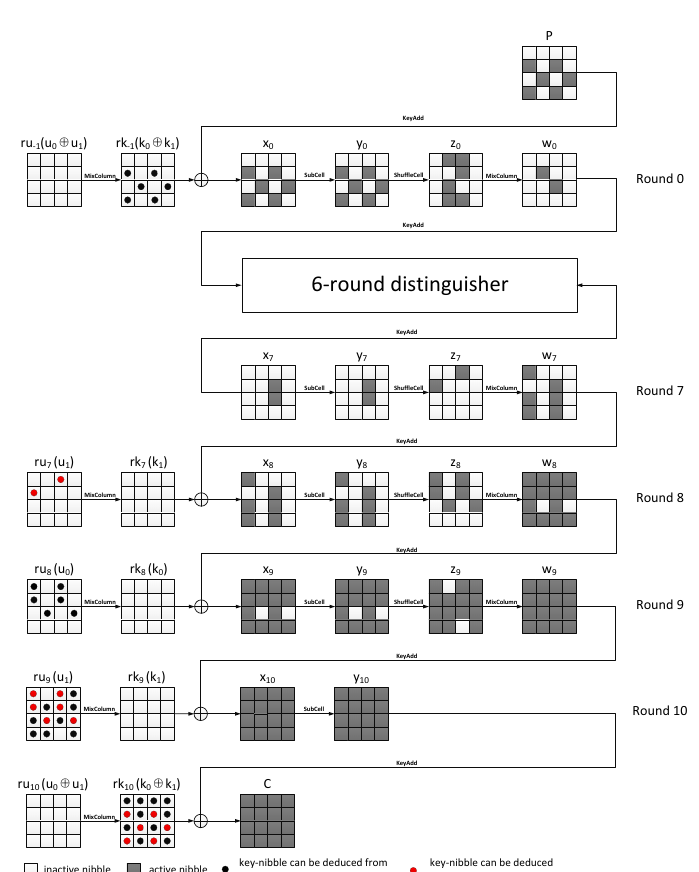
Figure 15: Online phase of the attack on 11-round